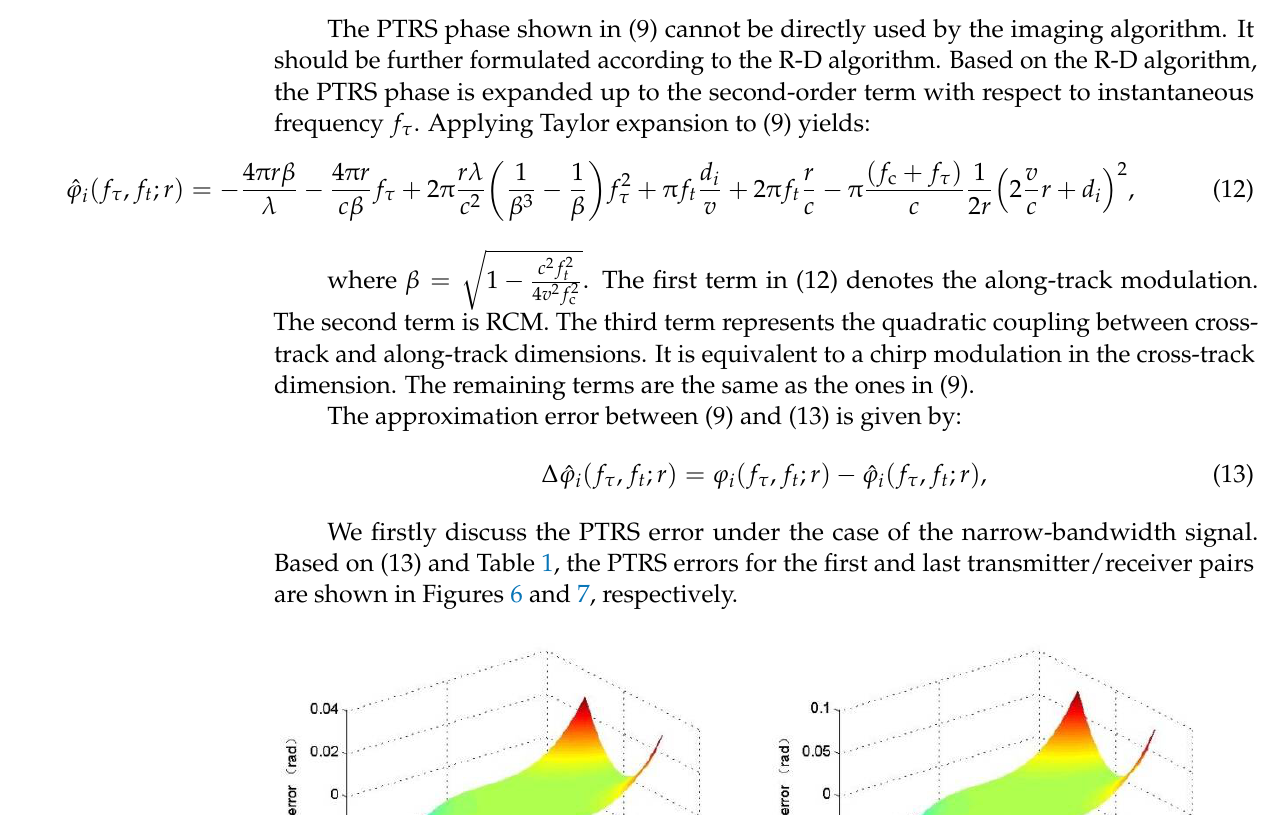
9 of 28 Figure 5. Signal model error for the last transmitter/receiver pair when the system works with wide-